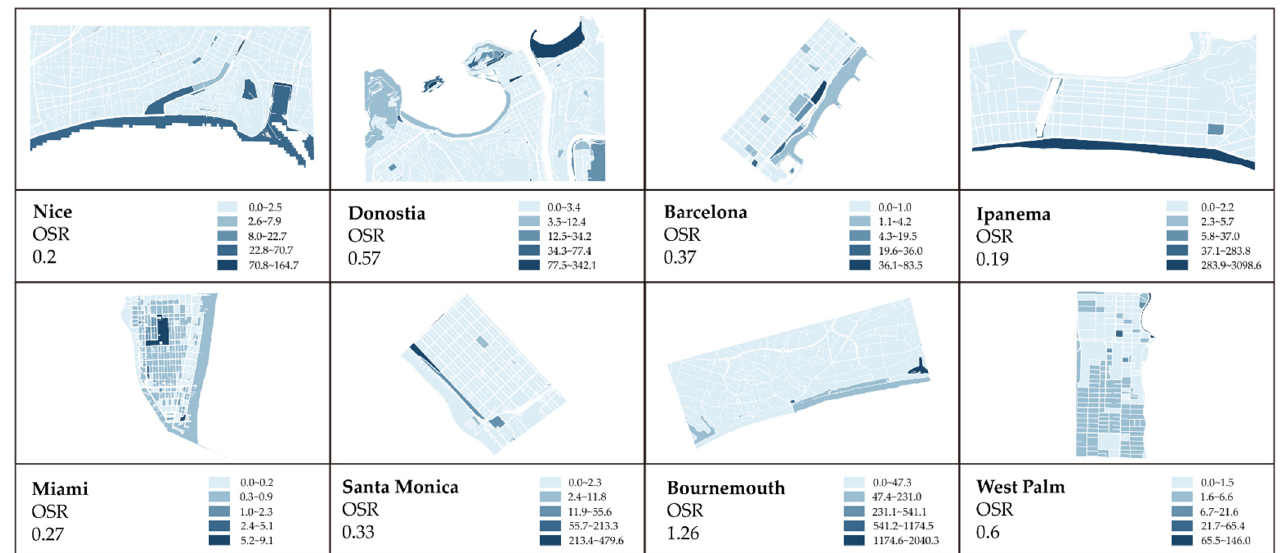
Figure 14. The distribution of OSR in successful coastal